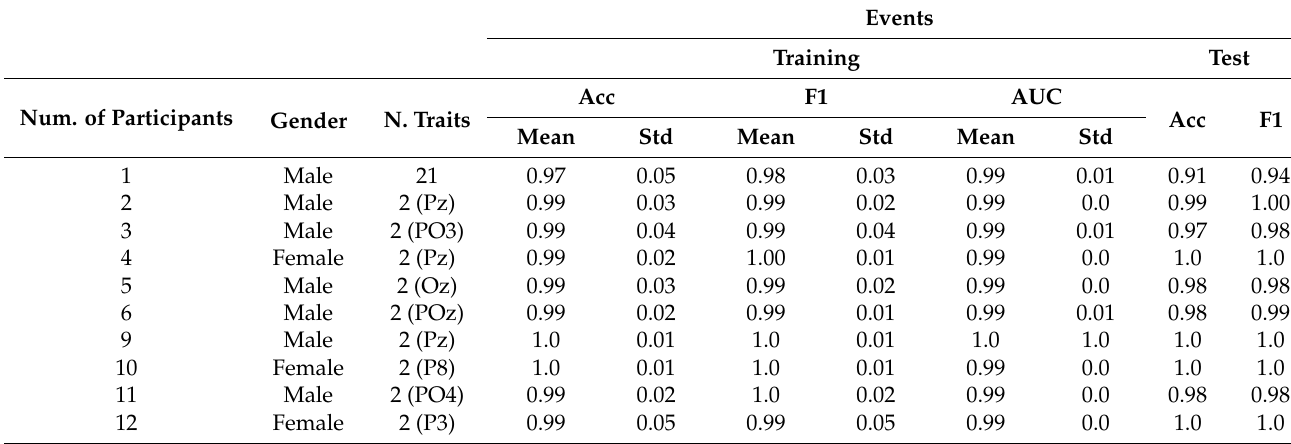
Table 6. Classification performance scores of positive and negative events per participants.